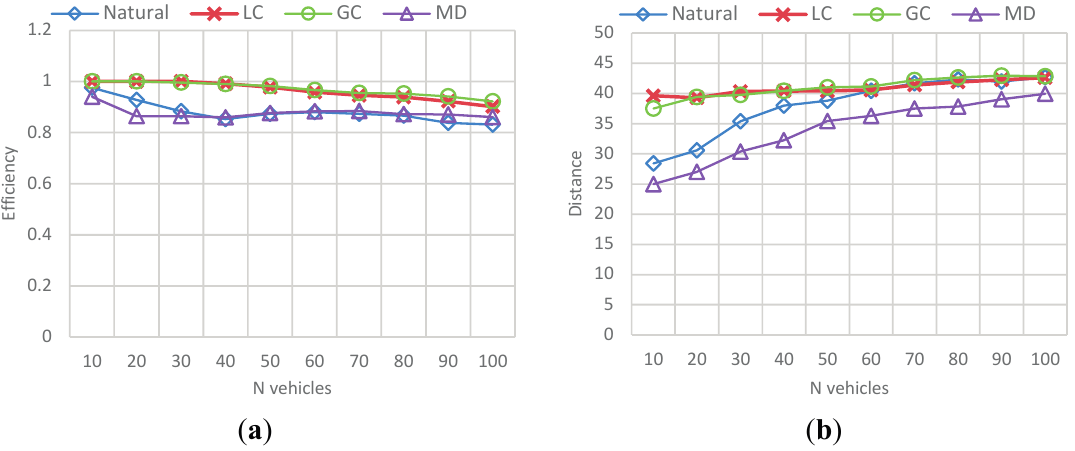
Figure 20. Behavior for route efficiency and trip distance in the N-vehicles scenario. ( a ) Mean efficiency value for each N-vehicles set; ( b ) Mean distance value for each N-vehicles set.